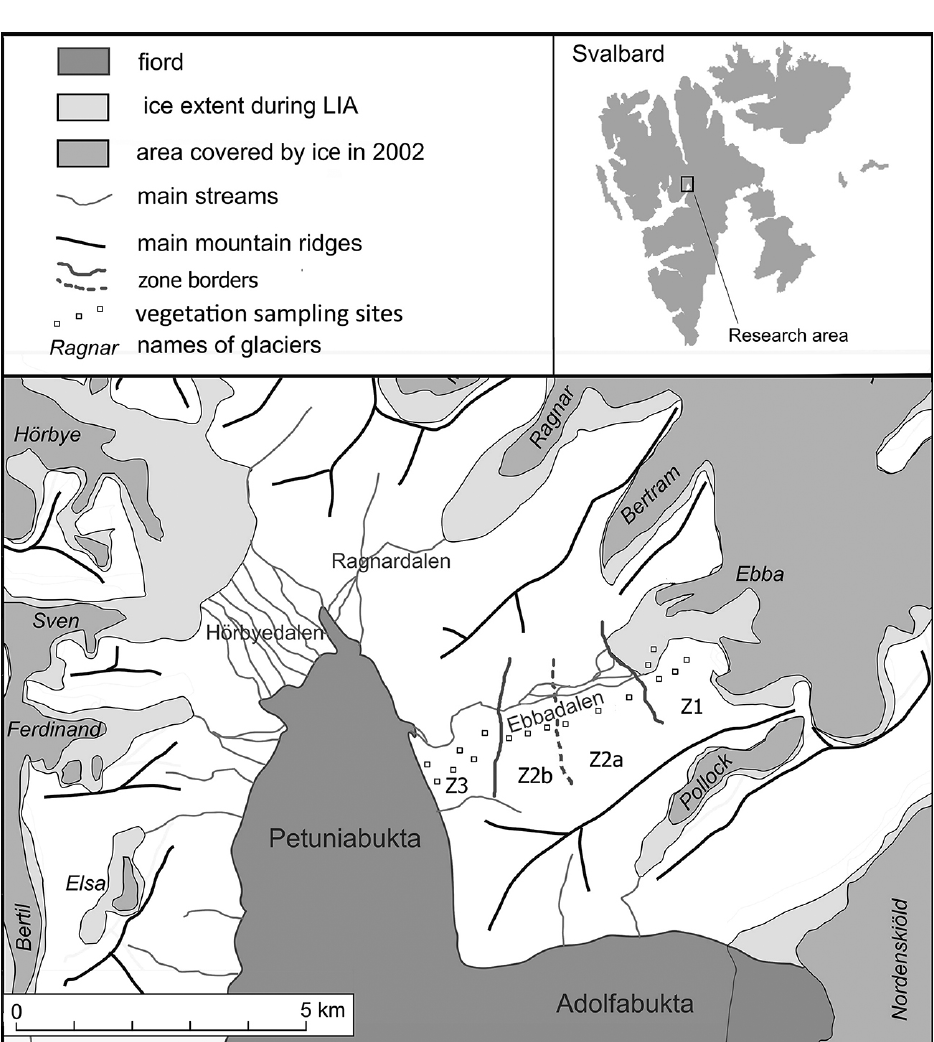
Fig. 1. Study site location and its division into zones of different geomorphic activity (modified after Rachlewicz et al.